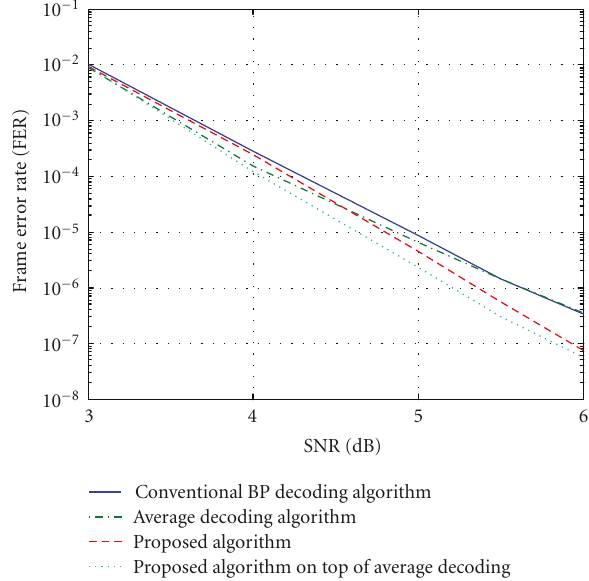
Figure 12: Performance results for MacKay(204,102) LDPC